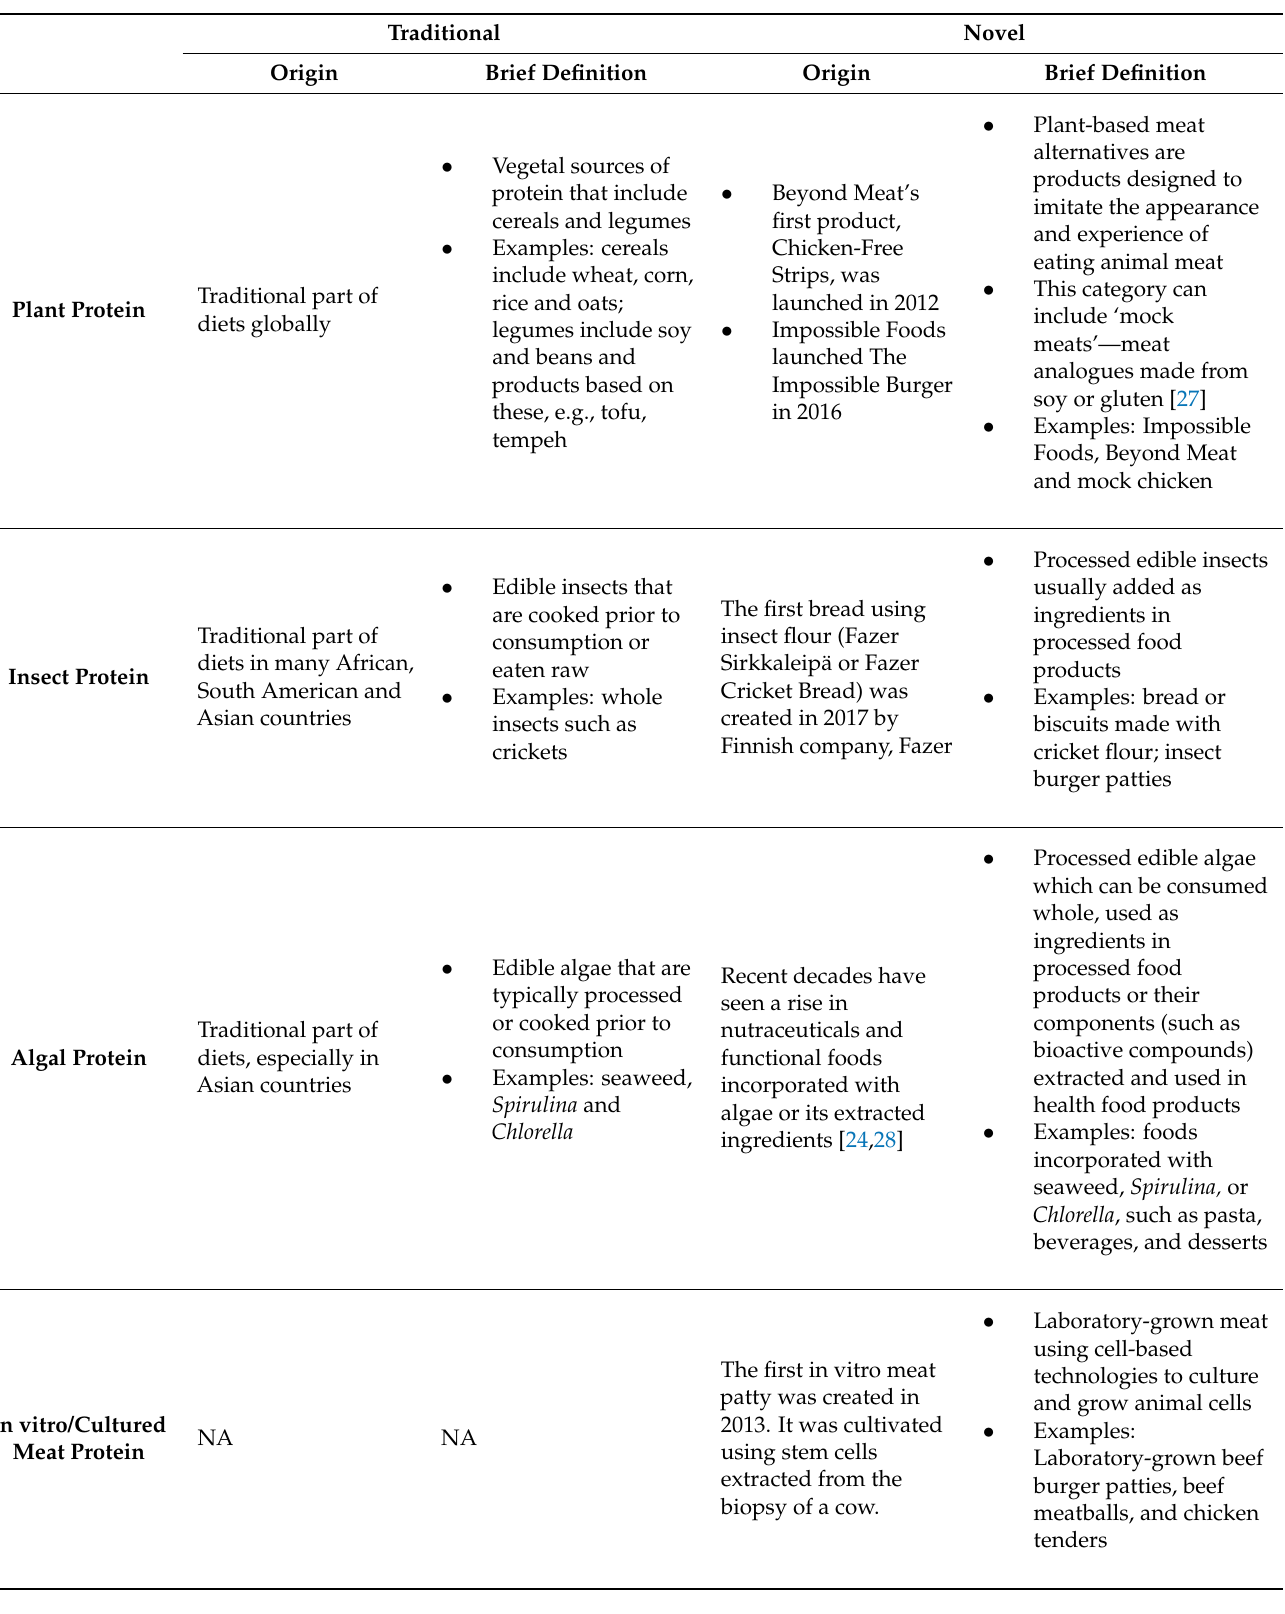
Table 1. Examples of alternative